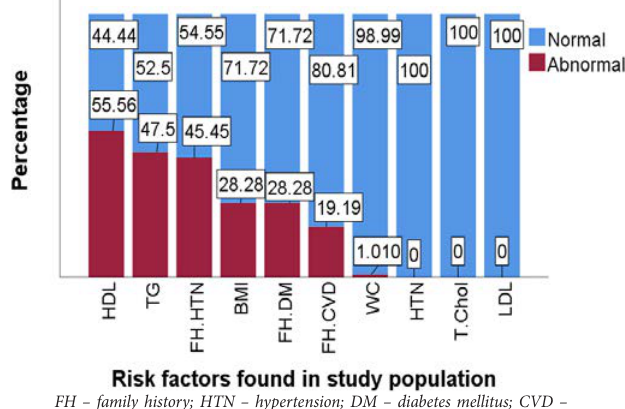
Fig 2 : Figure showing frequency of various cardiovascular risk factors among participants (N = 99)